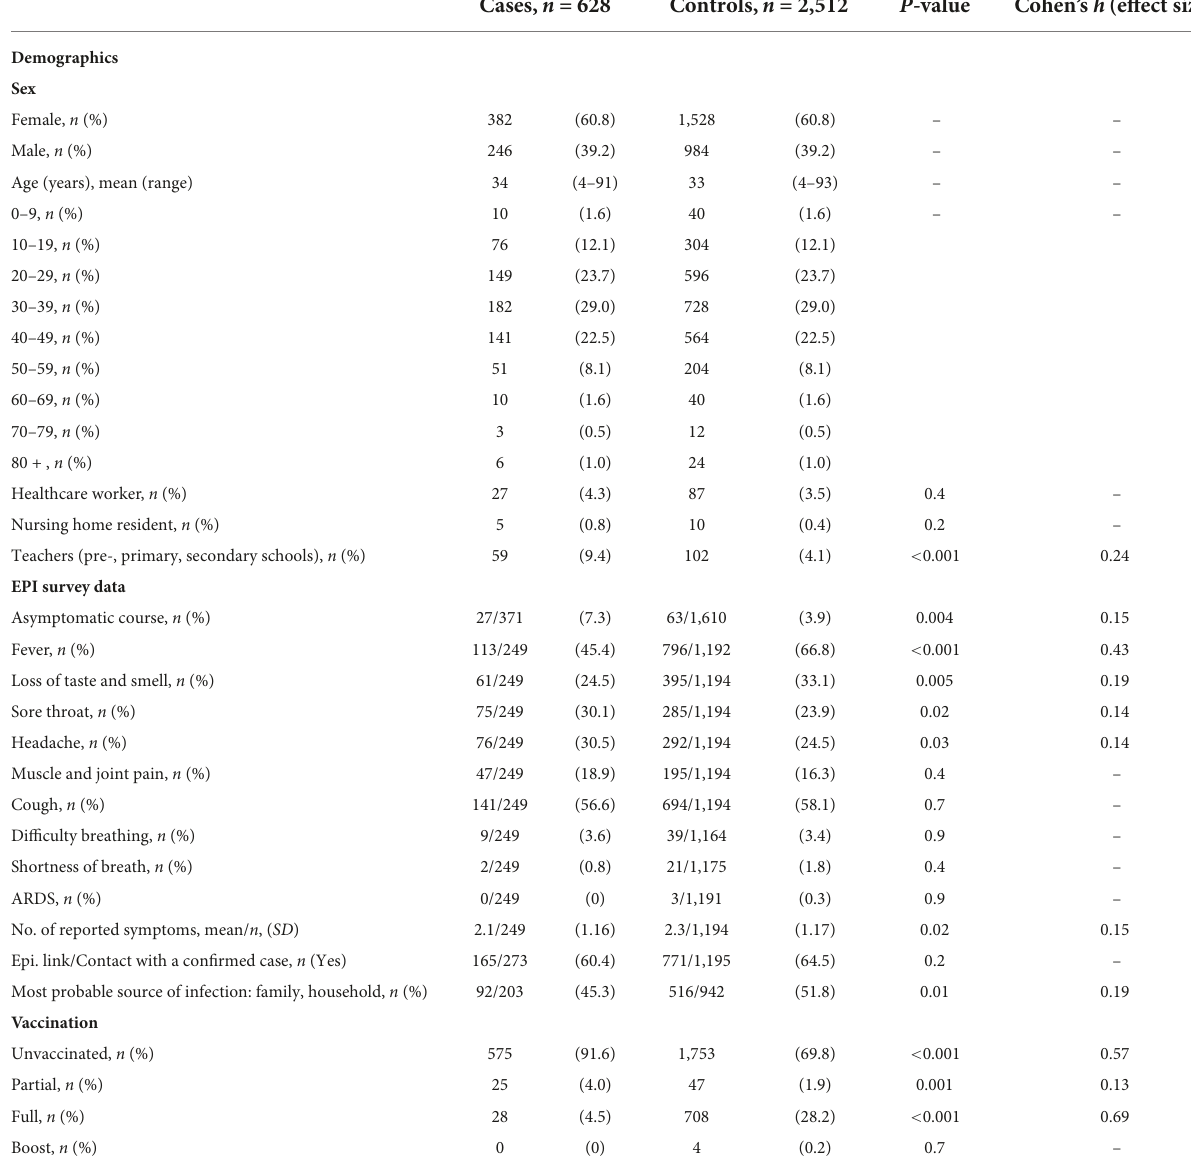
TABLE 1 Matching and non-matching variables in cases (individuals with Delta SARS-CoV-2 reinfection) and controls (individuals with initial Delta SARS-CoV-2